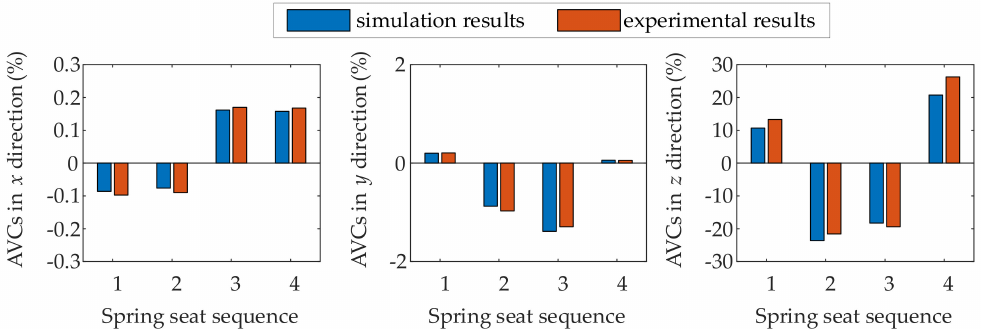
Figure 14. The amplitude variation coe ffi cients (AVCs) of each spring seat in the x , y , and z directions under spring failure kind 5, including the simulation results and experimental